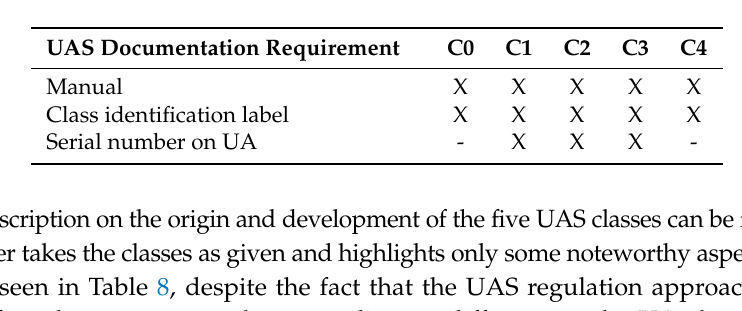
Table 10. UAS documentation and marking requirements excerpt